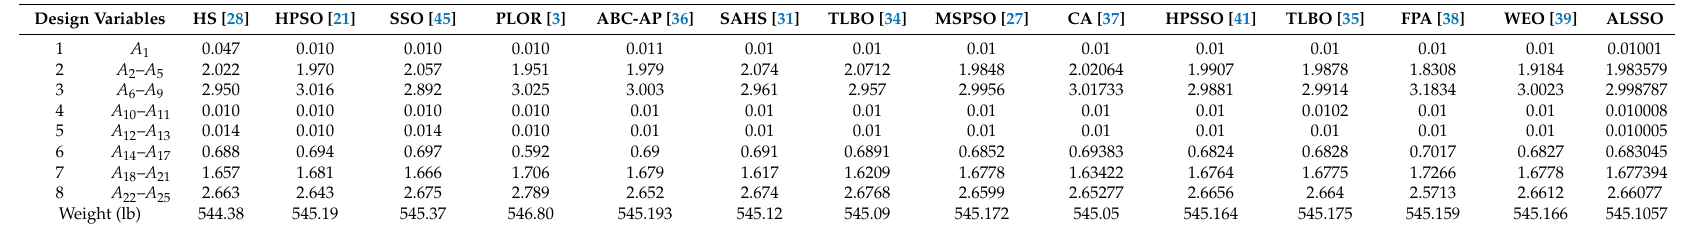
Table 5. Comparison of optimized designs for the 25-bar truss